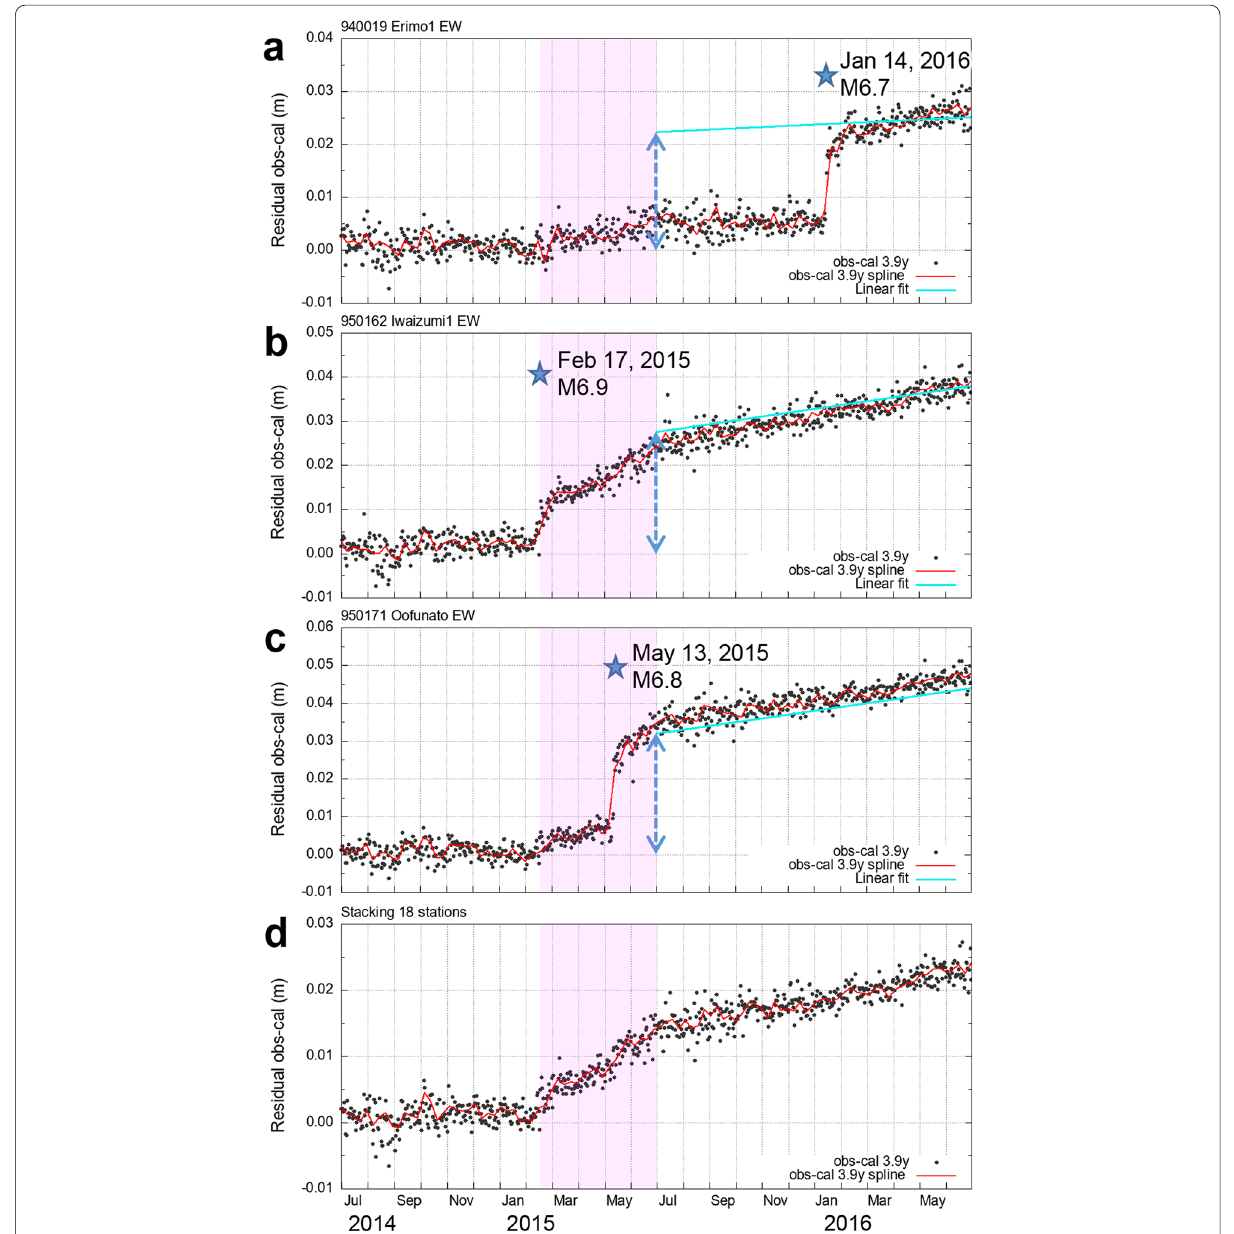
Fig. 4 Characteristic changes in residuals from 2015 to early 2016. The east–west (EW) components of the three observation stations a Erimo, b Iwaizumi1, c Oofunato, and d stacking of 18 stations (Fig. 5a). Black dots represent the residuals between the observed values and the 3.9-year model. Red lines indicate the residuals smoothed with the spline interpolation. Light blue lines depict the extensions of the straight lines fitted from December 2015 to December 2020. Stars indicate the time of the aftershocks near each observation station. Double-headed dotted lines present the values of gap